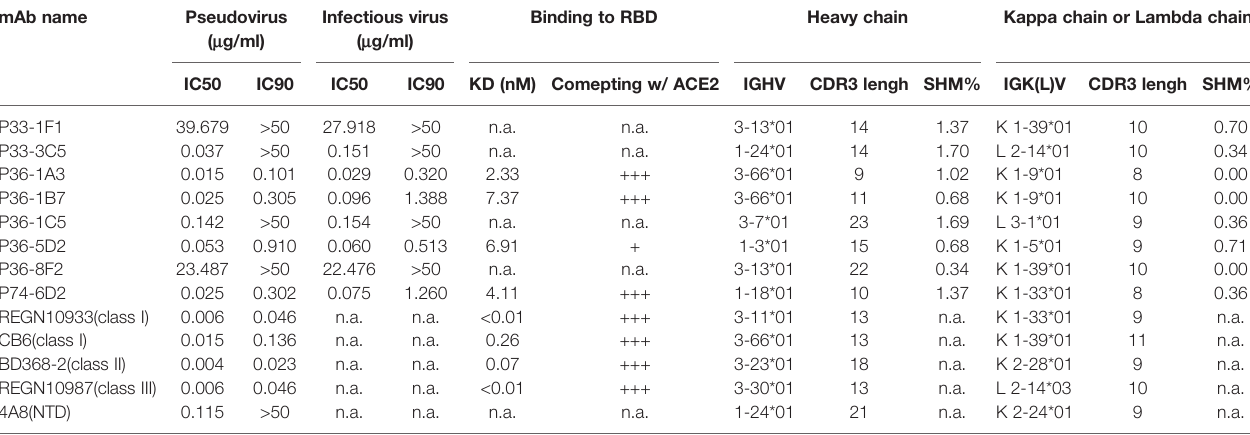
TABLE 1 | Binding capacity, neutralizing activity, and gene family analysis of eight monoclonal antibodies (mAbs) isolated from individuals infected with SARS-CoV-2 and fi ve published representative mAbs. mAb name Pseudovirus ( m